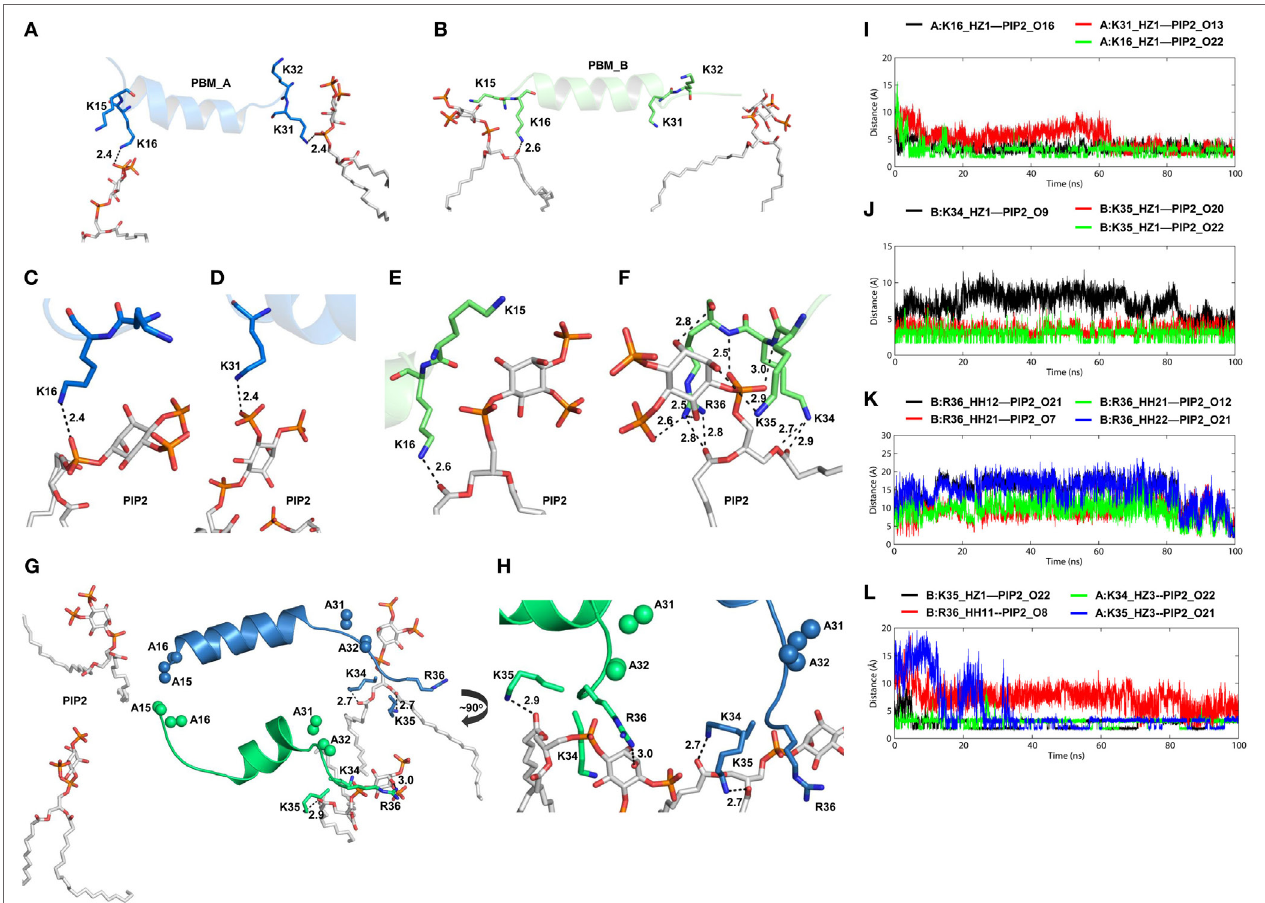
FigUre 6 | Intermolecular interactions between phosphatidylinositol (PI) 4,5-bisphosphate (PIP2) and positively charged residues of toll/interleukin 1 receptor domain-containing adaptor protein (TIRAP). Interaction of PIP2 with the PI-binding residues from (a) chain A and (B) chain B. (c–e) Close-up views of hydrogen bonds (H-bonds) formed between PIP2 and PI-binding residues. (F) One PIP2 trapped within a strong H-bond network formed by closely spaced K34, K35, and R36. (g) Interaction of PIP2 with TIRAP-PI-binding motif (PBM) with mutations K15 → A, K16 → A, K31 → A, K32 → A. Alanine residues are shown as sphere models, with blue for chain A and green for chain B. (h) A ~90° rotated view of panel (g) with close-up for clarity. Dashed lines represent H-bonds, and digits indicate distances in angstrom units. (i) H-bond distances between three PIP2-binding residues and PIP2. (J) Distance of H-bonds formed between K34 and K35 and PIP2. (K) H-Bond distances between atoms of R36 and the PIP2 headgroups. (l) Distance between interacting atoms of K34, K35, R36, and PIP2 in a mutant TIRAP as a function of